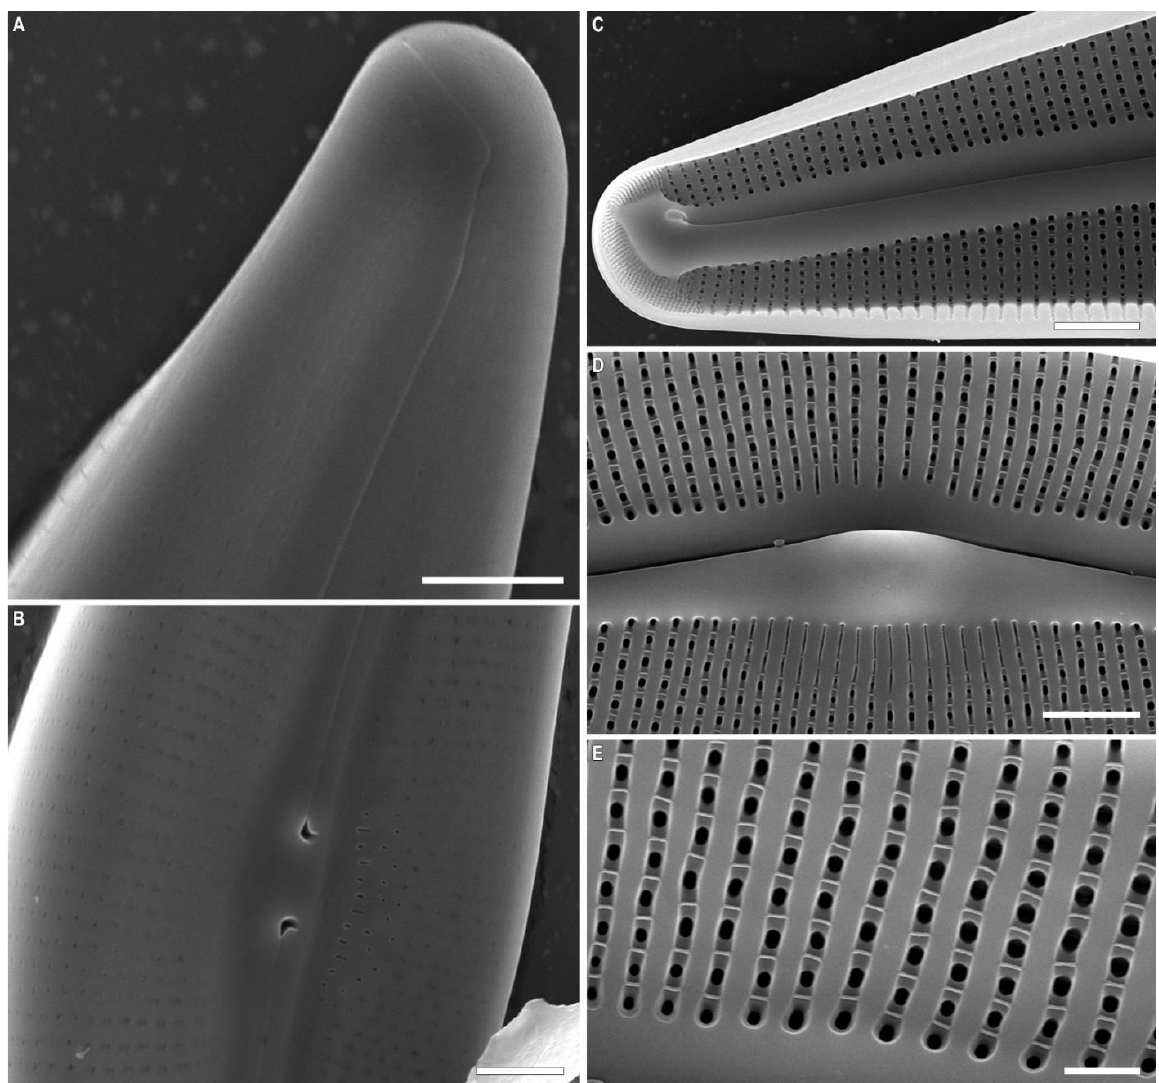
Figure 7. Cymbella baicalaspera Glushchenko, Kulikovskiy and Kociolek sp. nov. Strain B207. Scanning electron microscopy. ( A , B ) External view. ( C – E ) Internal view. ( A – D ) Central area. ( E ) Areolae. Scale bars ( A – D ) = 10 μm; ( E ) = 2 μm.